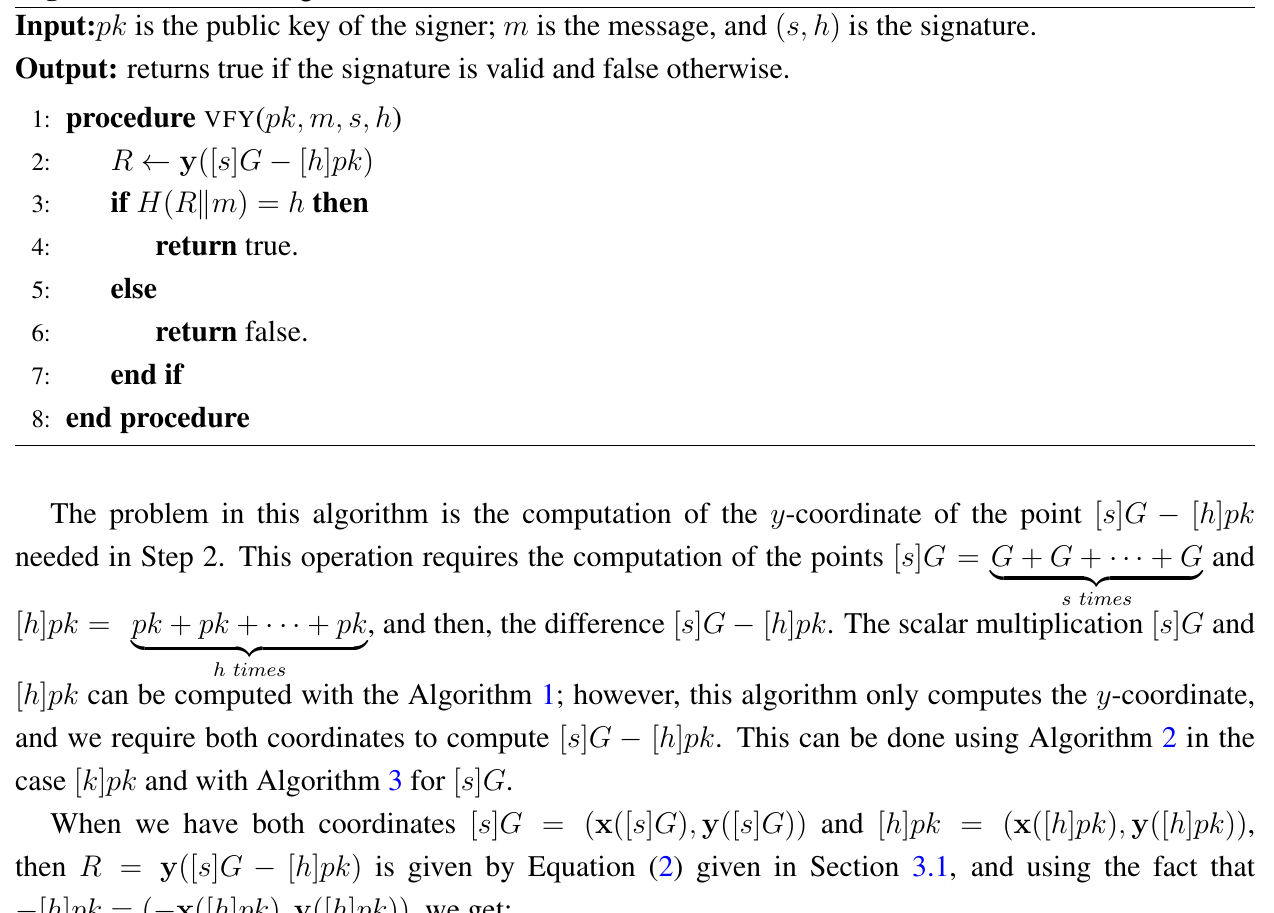
Algorithm 6 Schnorr signature